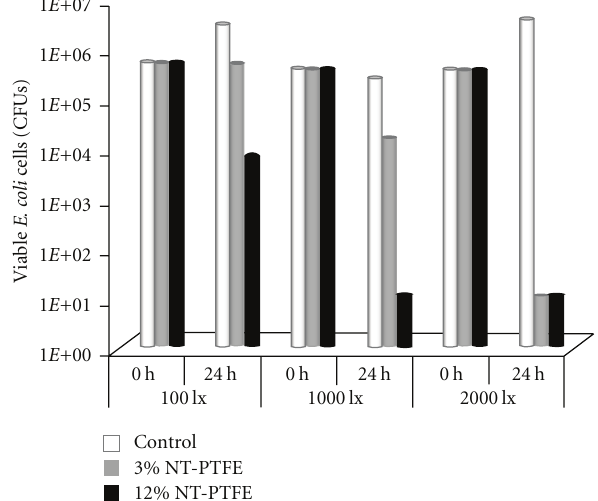
(1213cm − 1 ) and CF 2 (1155 cm − 1 , 639 cm − 1 ) adsorption peaks. B denotes the C = O (1800cm − 1 ) absorption peak.